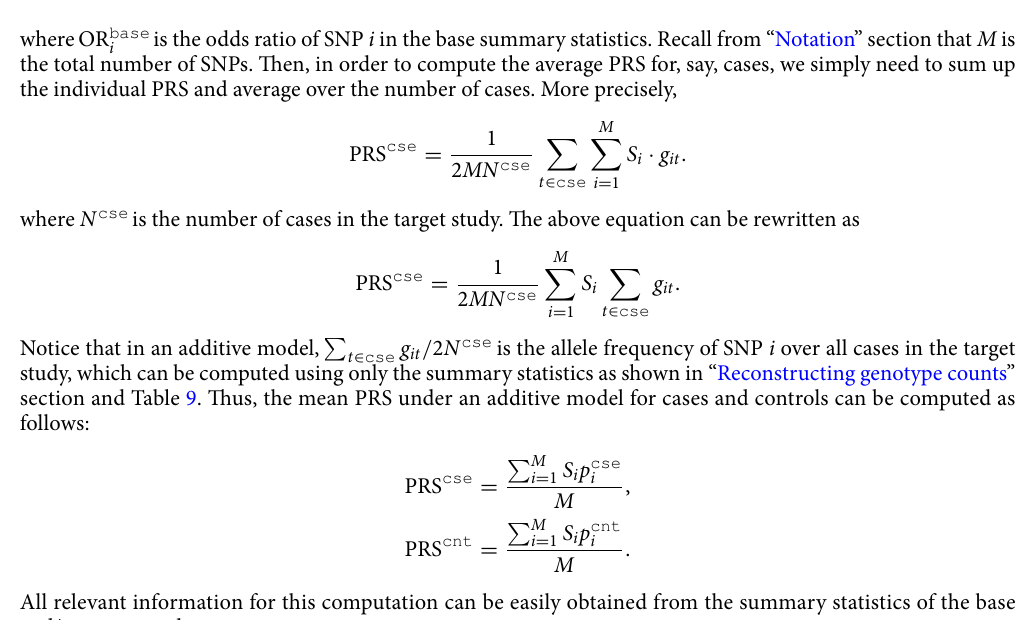
Table 12. The probability distribution of g it for SNP i . In this table, p cse 1 p cse cases and q i = i −